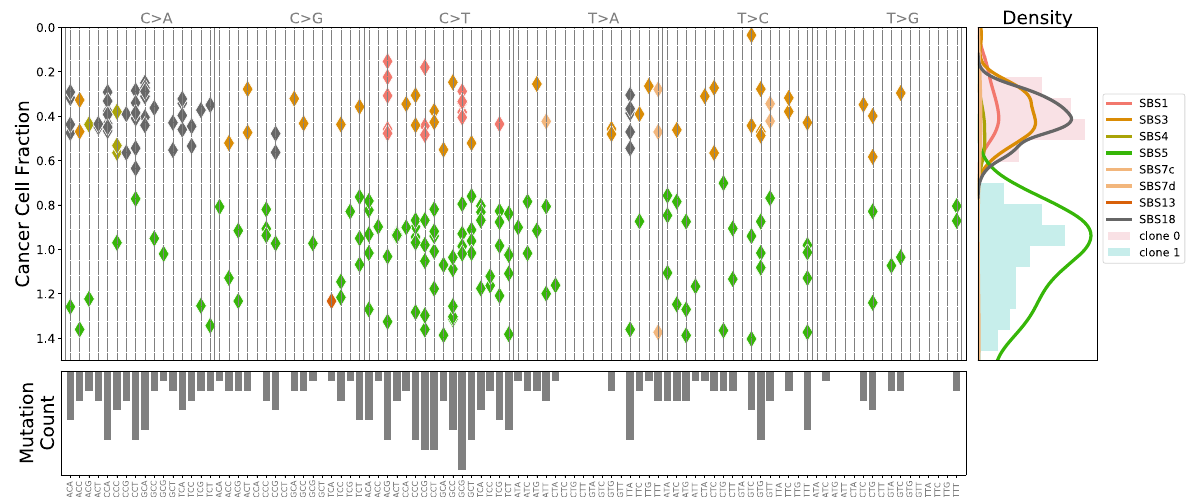
Fig. 1 CloneSig analysis of 246 SNVs obtained by WES of a sarcoma sample (patient TCGA-3B-A9HI). The main panel displays all SNVs in 2 dimensions: horizontally the mutation type, which describes the type of substitution together with the fl anking nucleotides, and vertically the estimated CCF, as corrected by CloneSig with the estimated mutation multiplicity. From these data CloneSig infers the presence of 2 clones and a number of mutational signatures active in the different clones. Each mutation in the main panel is colored according to the most likely mutational signature according to CloneSig. On the right panel, the CCF histogram is represented and colored with estimated clones, and superimposed with mutational signature density. The bottom panel represents the total mutation type pro fi le. The changing pattern of mutation types with CCF is clearly visible, illustrating the opportunity for CloneSig to perform joint estimation of ITH and signature activity, while most methods so far explore separately those data, considering solely the CCF histogram in the right panel for ITH analysis, or the mutation pro fi le of the bottom panel to infer mutational